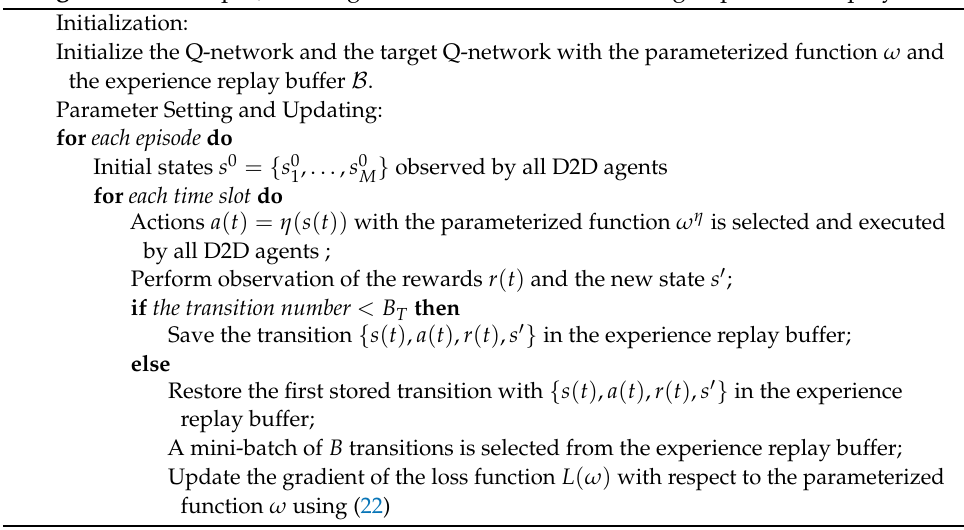
Algorithm 2: Deep Q-learning Based Solution Scheme using Experience